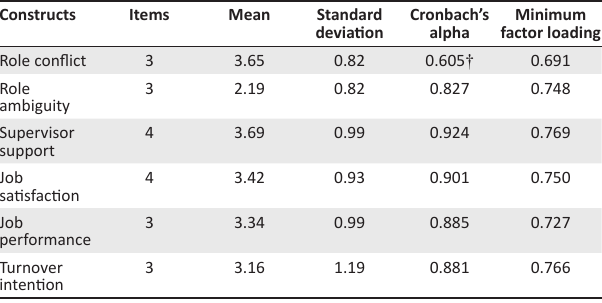
TABLE 2: Mean, standard deviation and construct reliabilities. Constructs